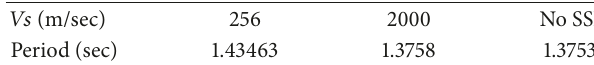
fundamental period of the rigid based 12-story building becomes equal to the case with SSI for the soil shear-wave velocity of 2000 m/s and above.